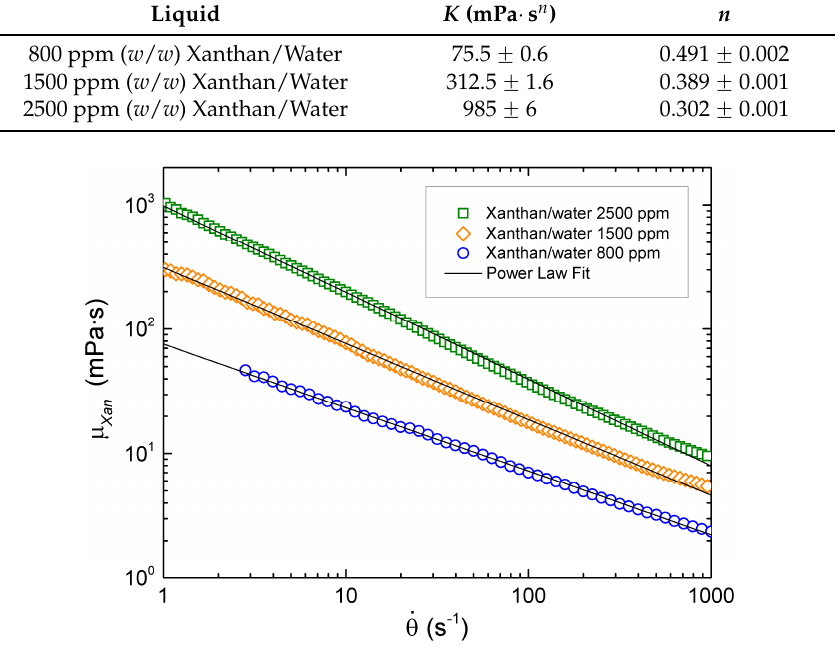
Figure 2. Viscosity characterization of xanthan solutions at different concentrations. Lines are K (cid:1837)θ(cid:4662) (cid:4666)(cid:3041)(cid:2879)(cid:2869)(cid:4667) fit to the data according to the power law fluid.